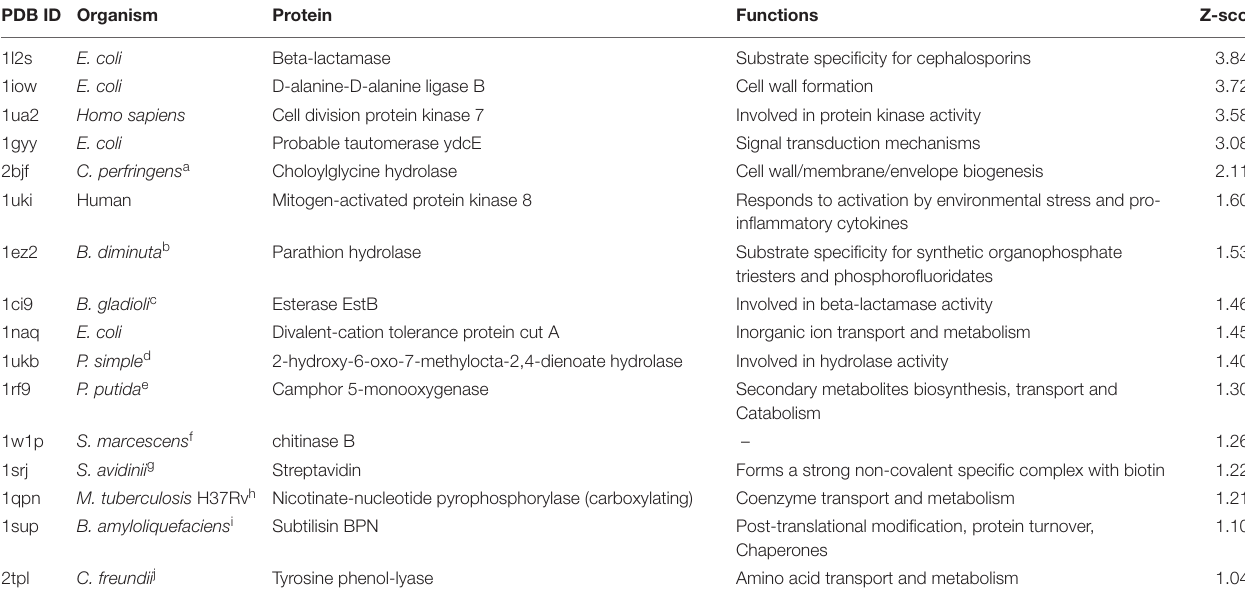
TABLE 1 | Predicted targets for compound PPDHMP identified in B. seminalis